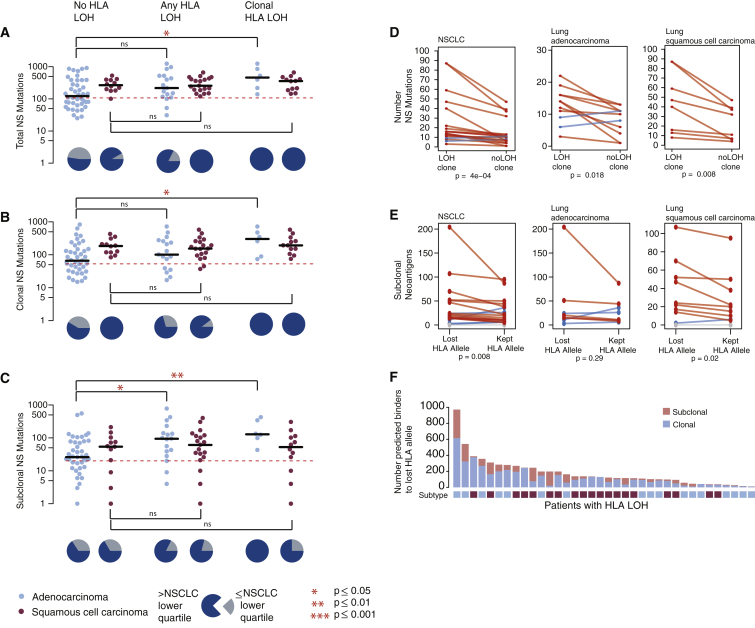
Non-synonymous Mutational Burden Associates with HLA LOH, and Neoantigens More Frequently Bind the Lost Allele(A) The total number of nonsynonymous mutations is plotted across different categories of HLA LOH for lung adenocarcinoma (light blue) and lung squamous cell carcinomas (magenta). Tumors were classified as having: no HLA LOH; any HLA LOH event, without taking into account the timing of the event; or clonal HLA LOH. The lowest total non-synonymous mutation quartile is indicated by the dashed red line and the proportion of tumors with a total non-synonymous mutational burden greater or less than that is indicated by the pie charts for each HLA LOH classification group.(B) The number of clonal non-synonymous mutations is plotted across different categories of HLA LOH for lung adenocarcinoma (light blue) and lung squamous cell carcinomas (magenta).(C) The number of subclonal non-synonymous mutations is plotted across different categories of HLA LOH for lung adenocarcinoma (light blue) and lung squamous cell carcinomas (magenta). All p values are calculated using an unpaired Wilcoxon test.(D) The number of non-synonymous mutations found in the clone harboring the HLA LOH event compared to the number of non-synonymous mutations in its sister clone, descended from the same ancestral cancer cell, but without HLA LOH. The p value is calculated using a paired Wilcoxon test.(E) The number of subclonal neoantigens predicted to bind to either the lost HLA allele or the kept HLA allele is indicated for all NSCLC tumors exhibiting HLA LOH, all lung adenocarcinoma tumors with HLA LOH, and all lung squamous tumors with HLA LOH. A red line indicates an elevated subclonal neoantigen mutation burden in the HLA LOH subclone compared to the subclone without HLA LOH, while blue indicates the converse. The p value is calculated using a paired Wilcoxon test.(F) The total number of mutations predicted to result in a binder to the lost allele is shown for all patients with at least one HLA LOH event. The mutation clonality is also indicated as either clonal (light blue) or subclonal (light red).See also Figure S4.